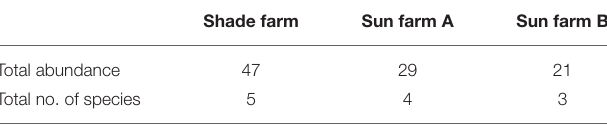
TABLE 3 | Invertebrate abundance and biodiversity comparison.